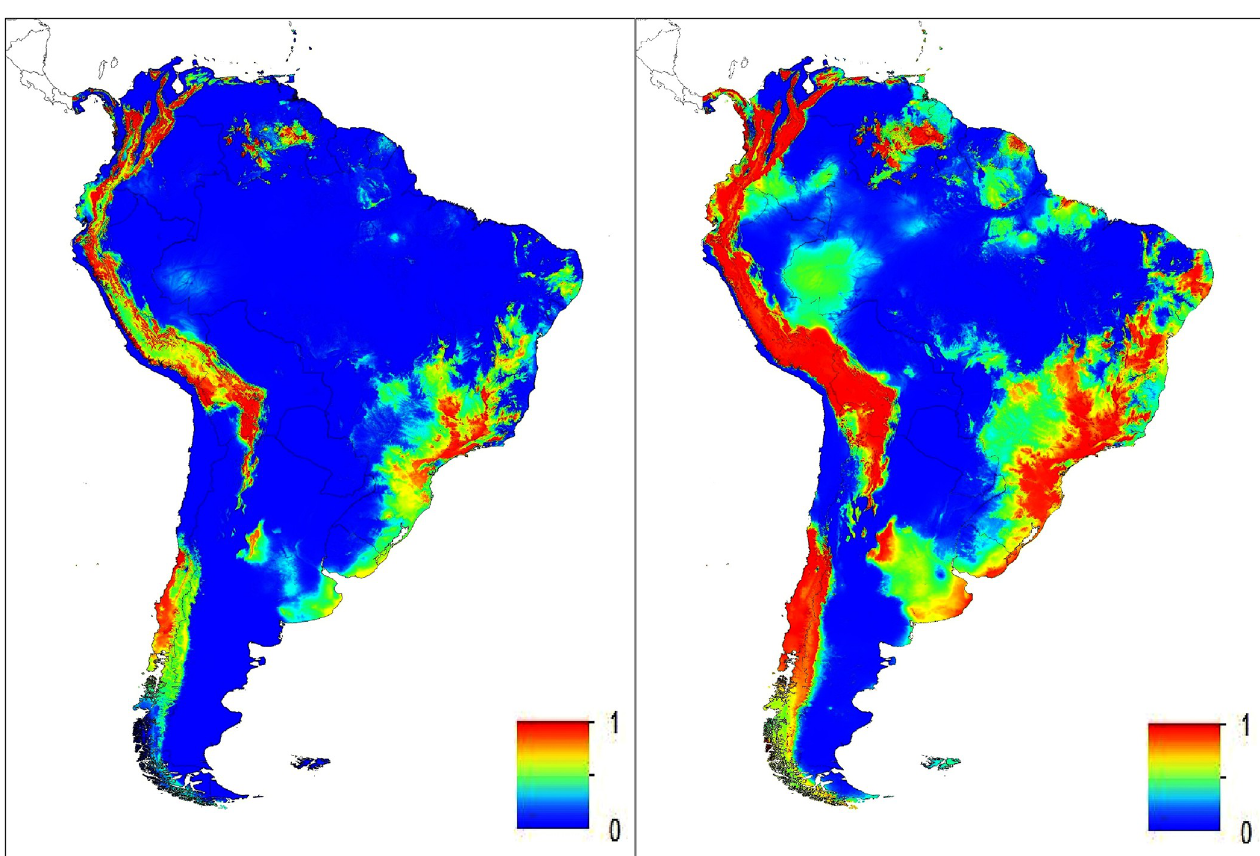
Fig 2. Overview of areas to be affected by Batrachochytrium dendrobatidis (Bd) predicted by the species distribution model maxent using Worldclim variables and Bd presence data throughout South America. Figure on the left shows the minimum suitability for Bd whilst the figure on the right shows the maximum projected predictions for Bd. Warmer colors indicate a higher suitability of the area for Bd